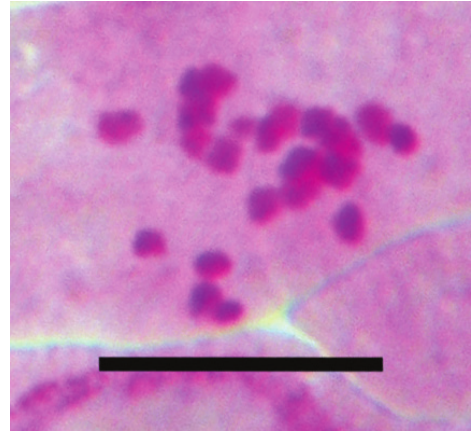
Figure 9. Taraxacum lucense Arrigoni, Ferretti & Padula, 2 n = 24. Scale bar: 10 μm. Taraxacum lucense Arrigoni, Ferretti & Padula (Asteraceae) Chromosome number: 2 n = 24 (Fig.